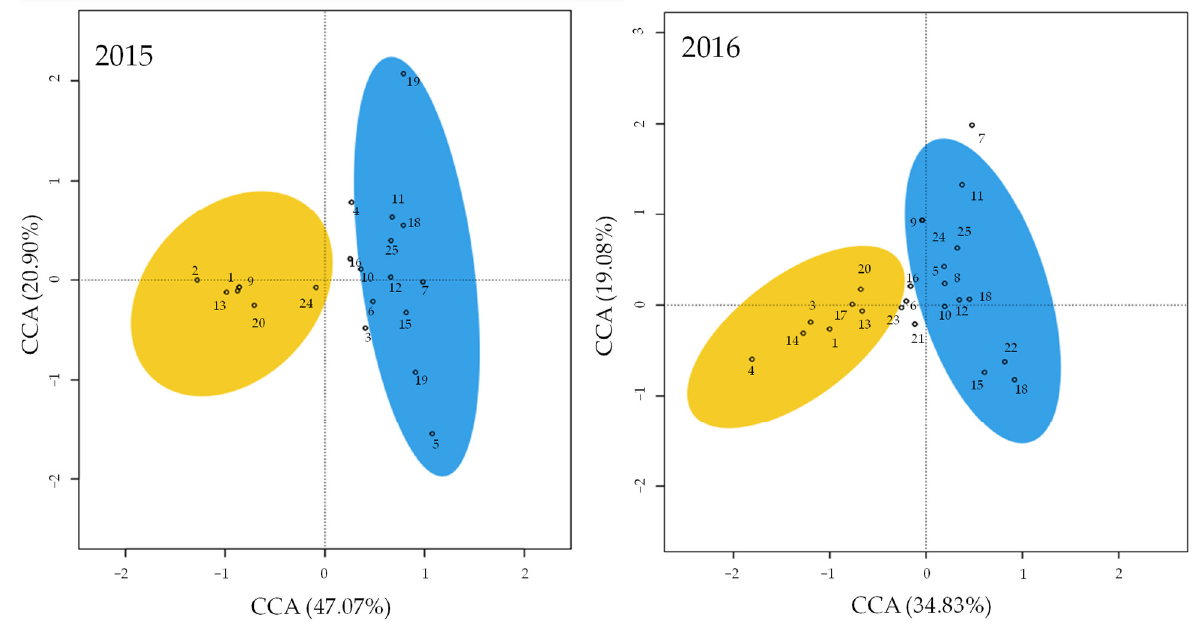
Figure 2. Ordination plot (canonical correspondence analysis CCA) for the complete pool of Coleoptera families found in the olive groves (blue) and shrubland (yellow) in Trás-os-Montes (Portugal) in 2015 and 2016. Ellipses represent the standard deviation. The numbers within the panels correspond to the numbers of the families in Table 1.